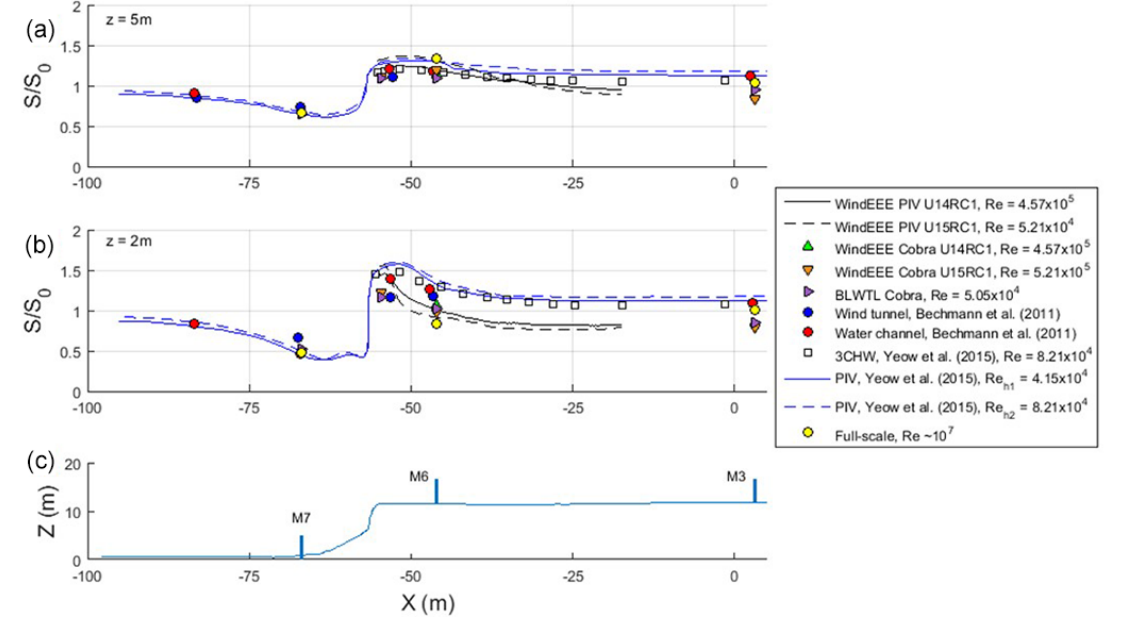
Figure 9. Horizontal profiles of speed-up ratio from PIV and Cobra probe measurements (WindEEE and BLWTL cases) at (a) z = 5m and (b) z = 2m above hill surface, with (c) showing hill profile. Results from full scale and other previous physical experiments presented for comparison.